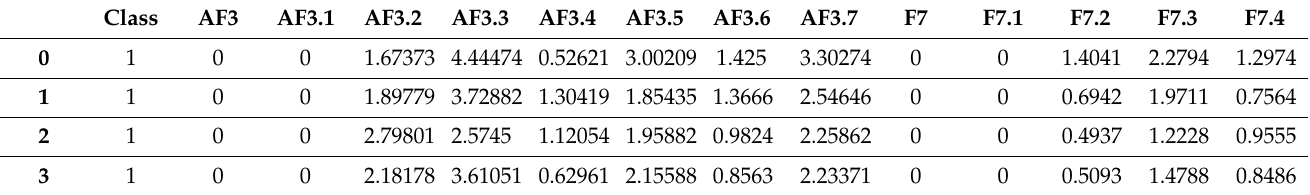
Table A1. Data acquired by Kaggle in numerical format.